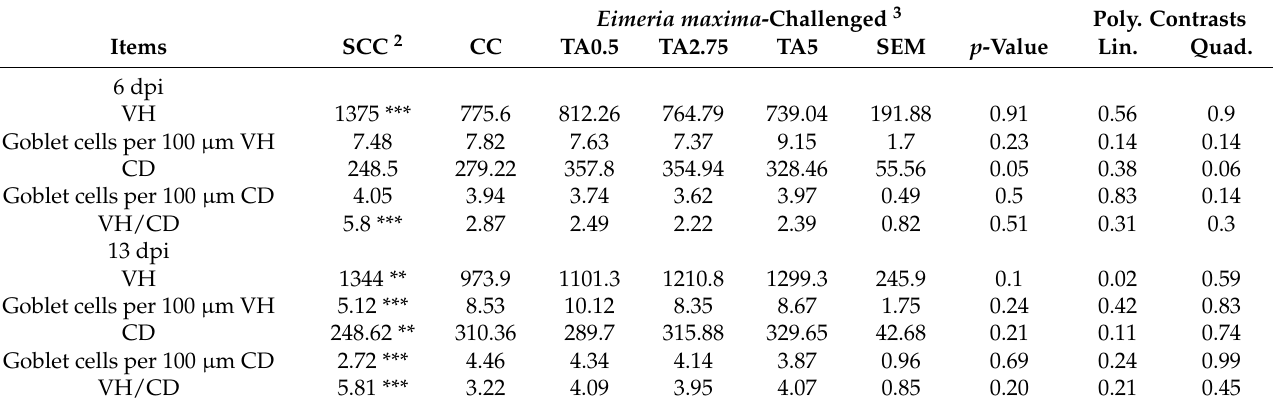
Table 9. Effects of tannic acid supplementation on villus height (VH, µ m), crypt depth (CD, µ